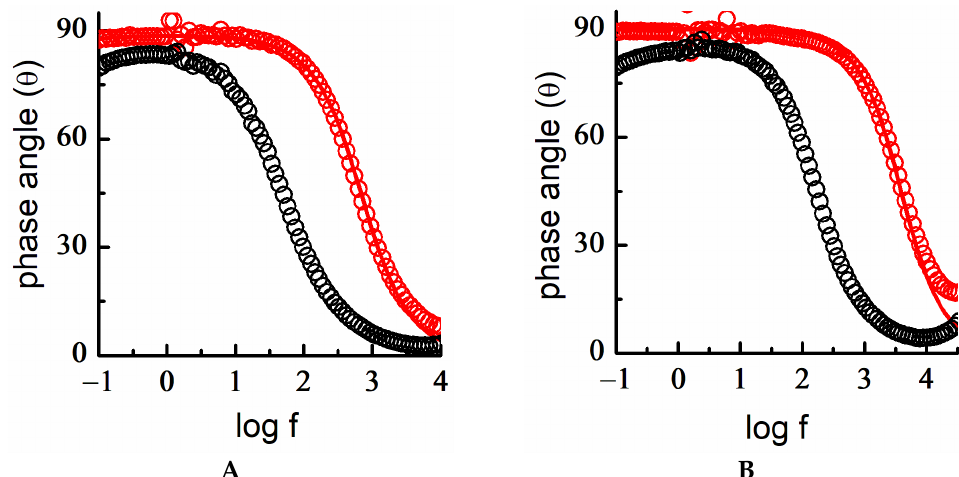
Figure 10. Electrochemical impedance spectra. Bode plot of bare Au 18K gold alloy (black circle) and DT-SAM/Au 18K (red circle) in ( A ) acidic medium, E = 0 V, fitting of experimental data to a [R(RQ)] equivalent circuit (red line) and ( B ) basic medium, E = −0 .3 V, fitting of experimental data to a [RC] equivalent circuit (red line).